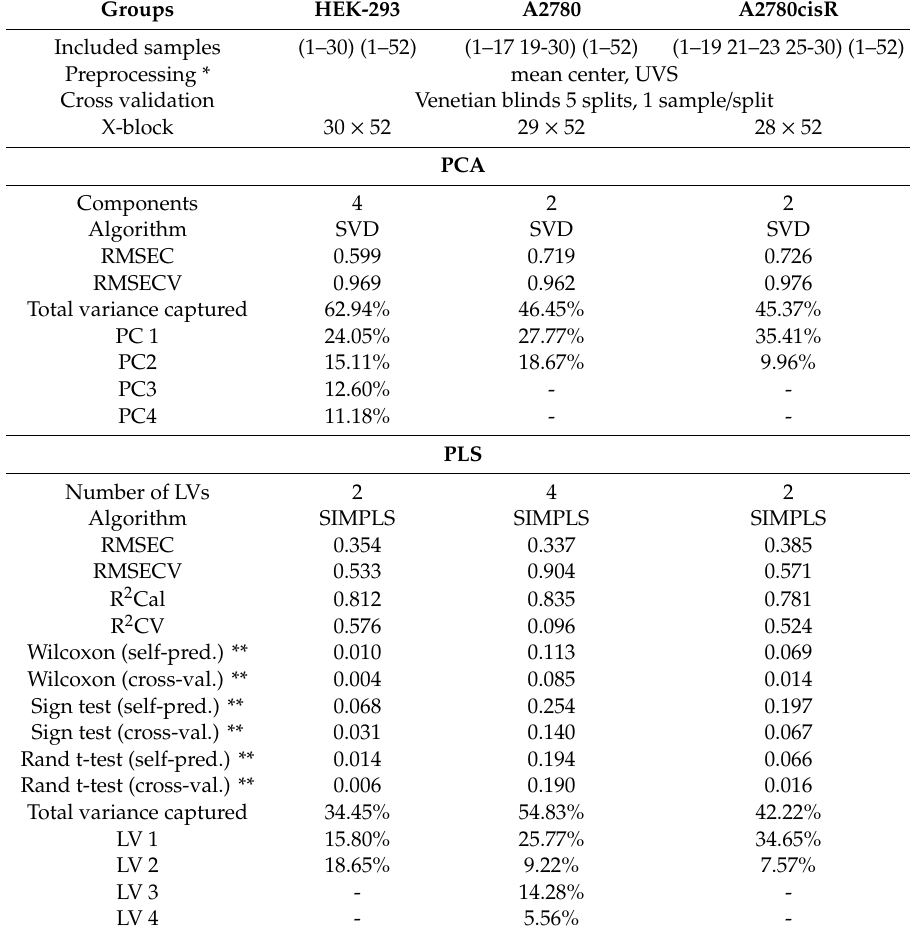
Table 2. Summary of parameters and statistical results of the PCAs and PLS shown in Figure 3. * In the case of PLS for both the x and y tables ** Values below 0.05 indicate significance at the 95%